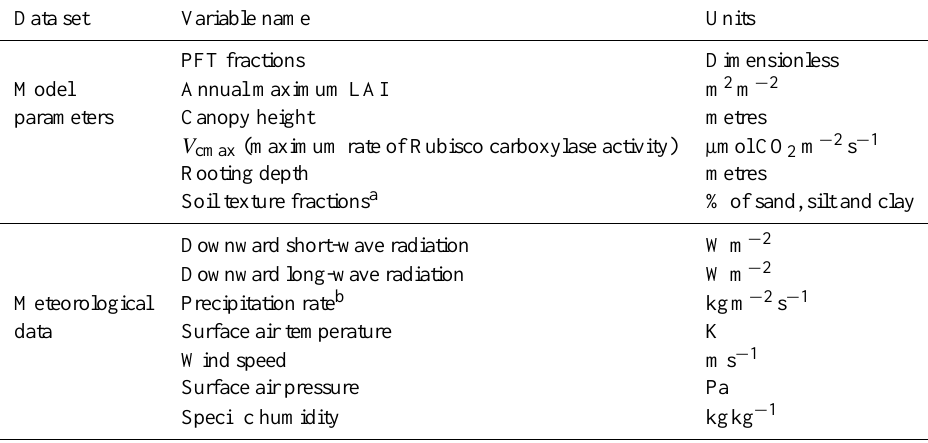
Table 1. Model parameters and meteorological variables that are altered between global and local model